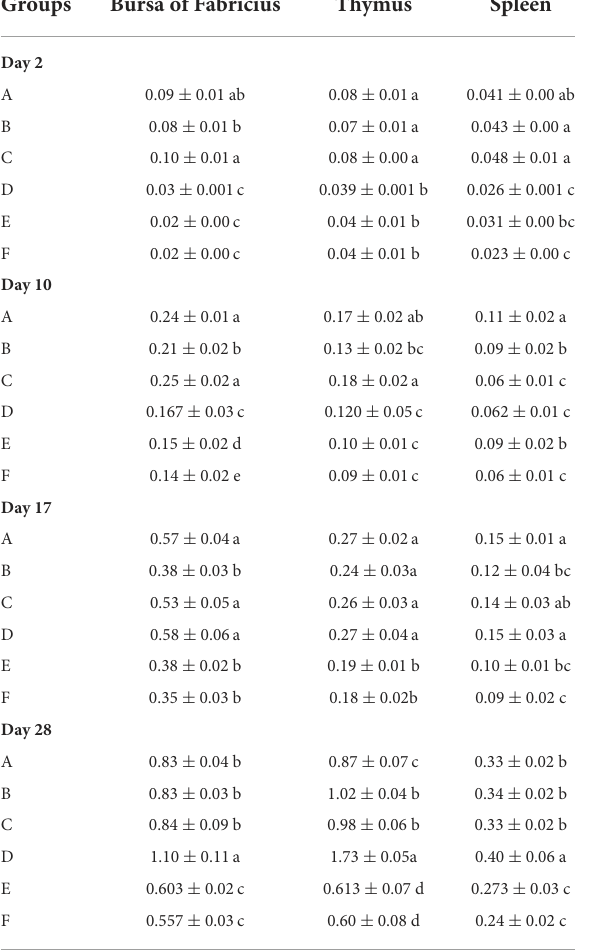
TABLE 7 Relative organ weights (mean ± SD) of the White Leghorn chicks administered live IBD vaccines in ovo and post-hatch. Groups Thymus